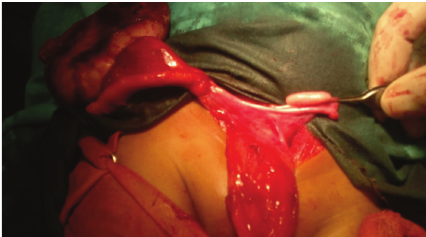
Figure 4: Right tuboovarian mass and normal left ovary and fallopian